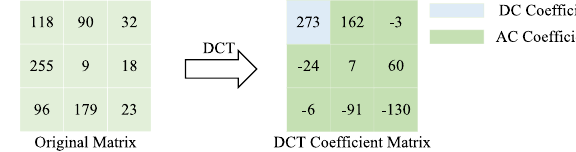
Figure 2. Data comparison before and after DCT.